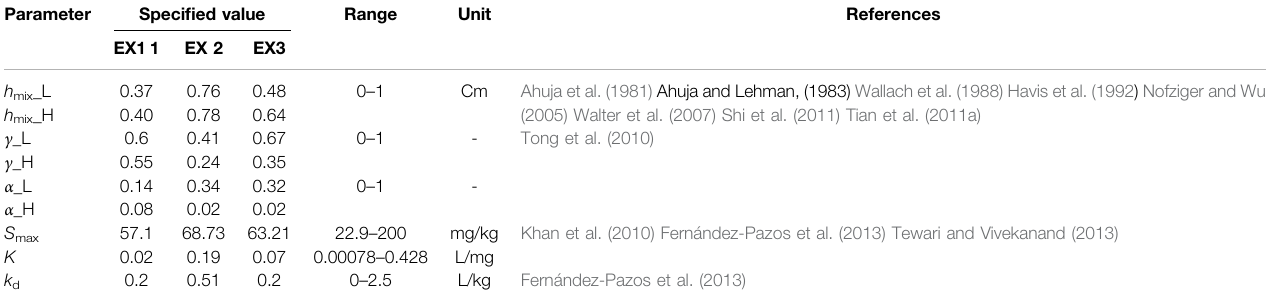
TABLE 2 | The value ranges for local and global sensitivity analysis of all parameters. L and H represent Langmuir and Henry. EX1, EX1, and EX3 are short for the three experiments, 1, 2, and 3. Parameter